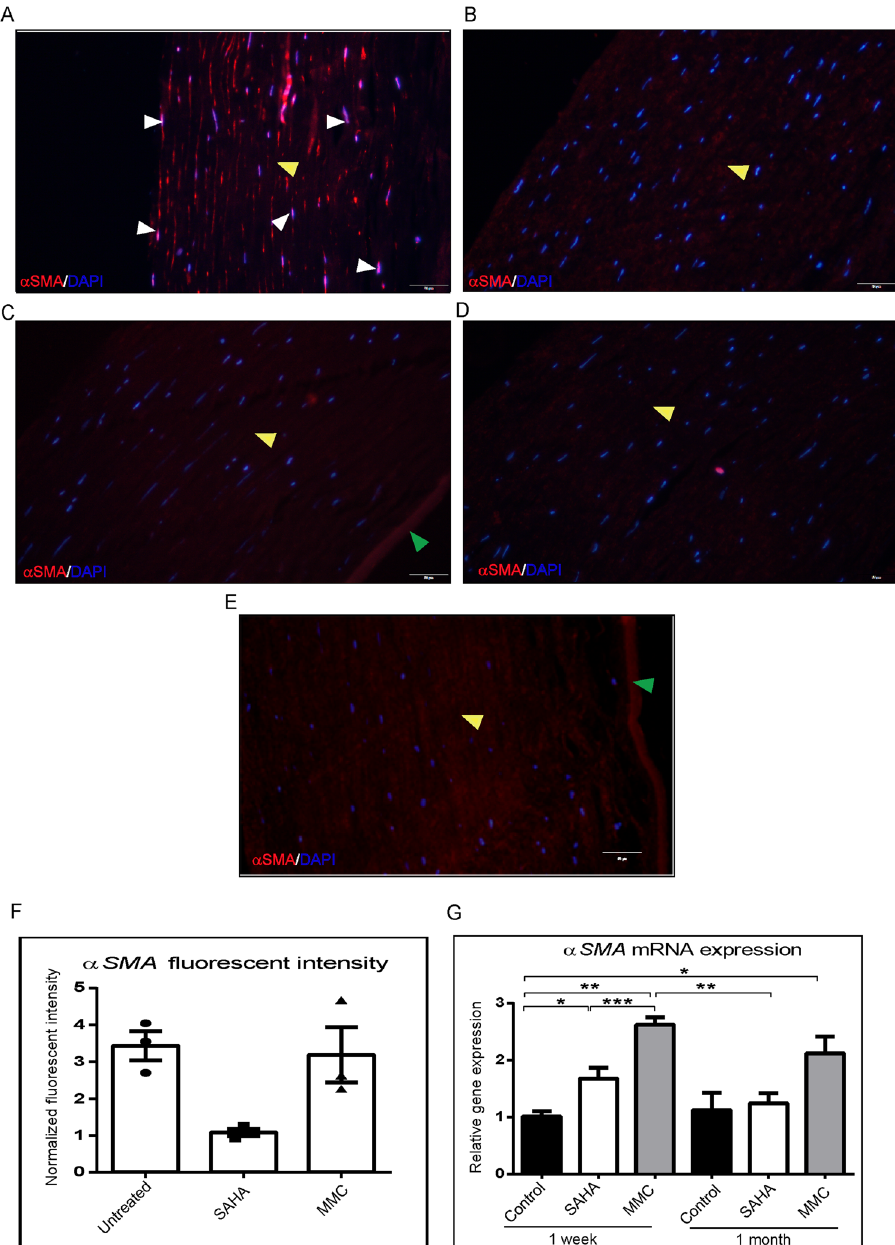
Figure 2. Effect of MMC and SAHA on cornea. Donor corneas were incubated for 1 month post surgery with MMC and SAHA. Representative immunofluorescence images of αSMA (red) and DAPI (blue) staining after MMC ( A ) and SAHA ( B ) treatment. Negative control for immunofluorescence images are corneas treated with MMC ( C ) and SAHA ( D ) and stained with secondary antibody only. Representative image of cornea cultured for 1 month without SAHA or MMC treatment and stained for αSMA (red) and DAPI (blue) ( E ). The white arrow heads show the αSMA positive staining, the yellow arrow head shows the stromal region and the green arrow depicts the endothelial layer of the cornea. mRNA expression of corneas (n = 4) treated with MMC (0.005%) and SAHA (5 µM) for 1 week and 1 month for αSMA levels ( G ). The mRNA levels of the gene of interest were normalized with the expression levels of β-actin gene. Mann- Whitney test for independent samples were run to get statistical significance. Images were quantified using Image J 1.48 version software (http://image j.nih.gov/ij/) and statistical analysis performed using statistical software GraphPad PRISM Ver